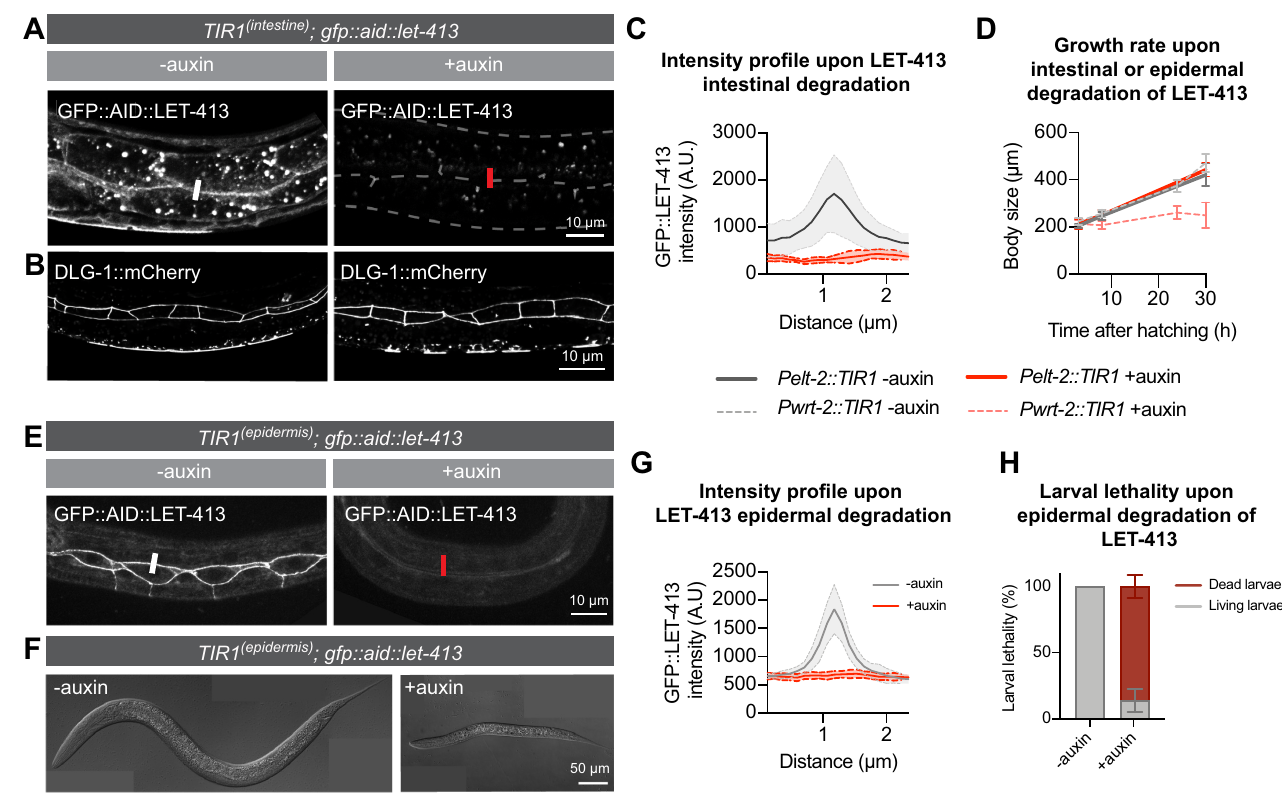
Fig 2. LET-413 is essential in the larval epidermis, but not the intestine. ( A ) Distribution of LET-413 in the intestines of Pelt-2 :: TIR1 :: BFP; GFP :: AID :: let- 413; dlg-1 :: mCherry animals 36 h post hatching in the absence (-auxin) or presence (+auxin) (strain BOX530). Images are a single focal plane at the level of junctions between opposing intestinal cells. White and red bars are an example of sites used for fluorescence intensity quantification in C. ( B ) Distribution of DLG-1::mCherry in the same animals as in A. Images are maximum intensity projections of the intestinal cell junctions. ( C ) Intensity profiles of GFP::LET-413 fluorescence at junctions of opposing intestinal cells in Pelt-2 :: TIR1 :: BFP; GFP :: AID :: let-413; dlg-1 :: mCherry animals in the absence (-auxin) or presence (+auxin) of auxin for 30 h (strain BOX530). Solid lines and shading represent mean ± SD. N = 6 animals for -auxin and 4 animals for +auxin. ( D ) Growth curves of Pelt-2 :: TIR1 :: BFP; GFP :: AID :: let-413 and Pwrt-2 :: TIR1 :: BFP; GFP :: AID :: let-413 animals in the absence (-auxin) or presence (+auxin) of auxin (strains BOX449 and BOX530). Solid lines represent animals that express TIR1 in the intestine ( Pelt2 :: TIR1 :: BFP )and dashed lines in the epidermis ( Pwrt2 :: TIR1 :: BFP ). Data show mean ± SD. N = 8, 10, and 10 animals for Pelt2 :: TIR1 -auxin; 13, 13, and 10 for Pelt2 :: TIR1 +auxin; 14, 14, 13 and 10 for Pwrt2 :: TIR1 -auxin; and 14, 16, 28, and 11 for Pwrt2 :: TIR1 +auxin. ( E ) Distribution of LET-413 in the epidermis of Pwrt-2 :: TIR1 :: BFP; GFP :: AID :: let-413 L1 stage animals in the absence (-auxin) or presence (+auxin) of auxin for 2 h (strain BOX449). White and red bars are an example of sites used for fluorescence intensity quantification in G. ( F ) Example of growth of Pwrt-2 :: TIR1 :: BFP; GFP :: AID :: let-413 animals in the absence (-auxin) or presence (+auxin) of auxin 24 h post hatching. ( G ) Intensity profiles of GFP::LET-413 fluorescence at seam–hyp7 junctions in Pwrt-2 :: TIR1 :: BFP; GFP :: AID :: let-413 animals in the absence (-auxin) or presence (+auxin) of auxin for 2 h (strain BOX449). Solid lines and shading represent mean ± SD. N = 5 animals for -auxin and 4 for +auxin. ( H ) Percentage of larval lethality upon degradation of epidermal LET-413 in Pwrt-2 :: TIR1 :: BFP; GFP :: AID :: let-413 larvae grown in the presence of auxin from hatching (strain BOX449). Data show mean ±